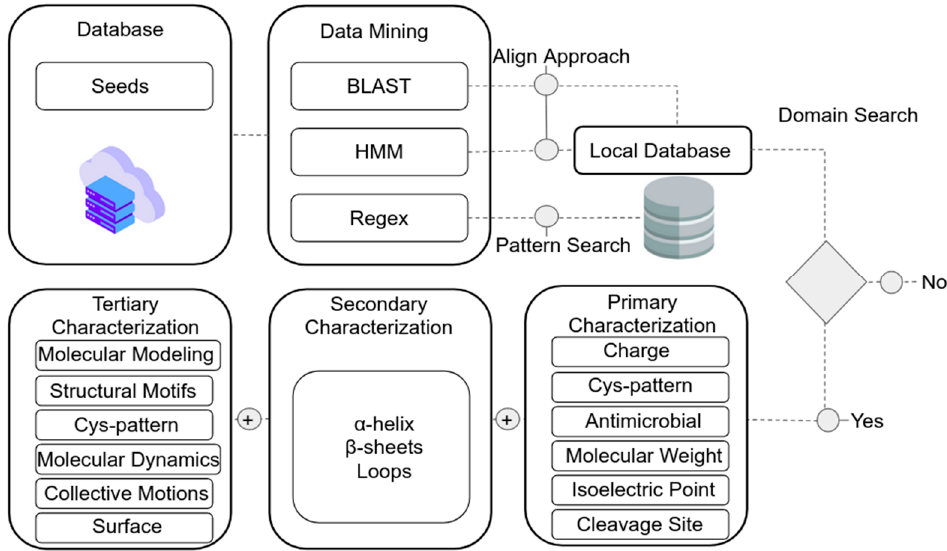
Figure 5. Flowchart with the steps required to identify nsLTP sequences from omics databases (nucleotide and amino acid sequences).